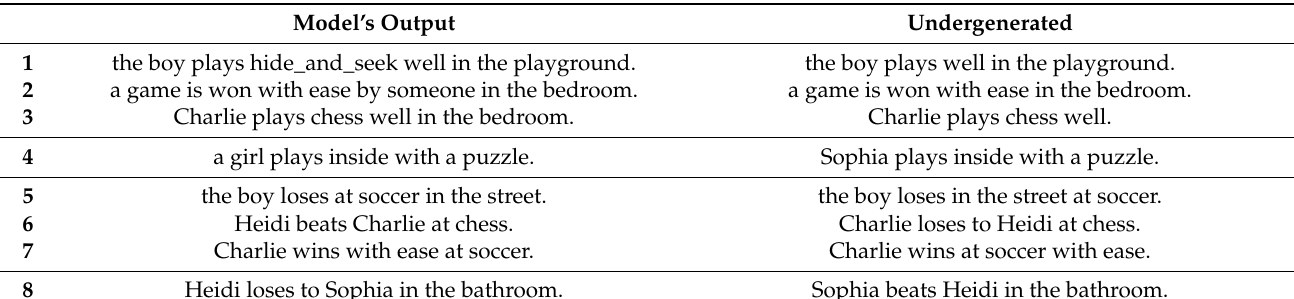
Table A1. Representative examples of undergeneration. Model’s